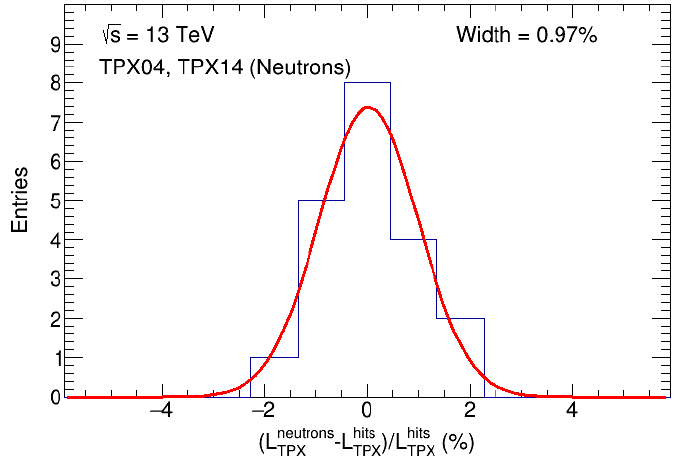
− L hits ) / L hits . A Gaussian fit is applied. The TPX TPX TPX